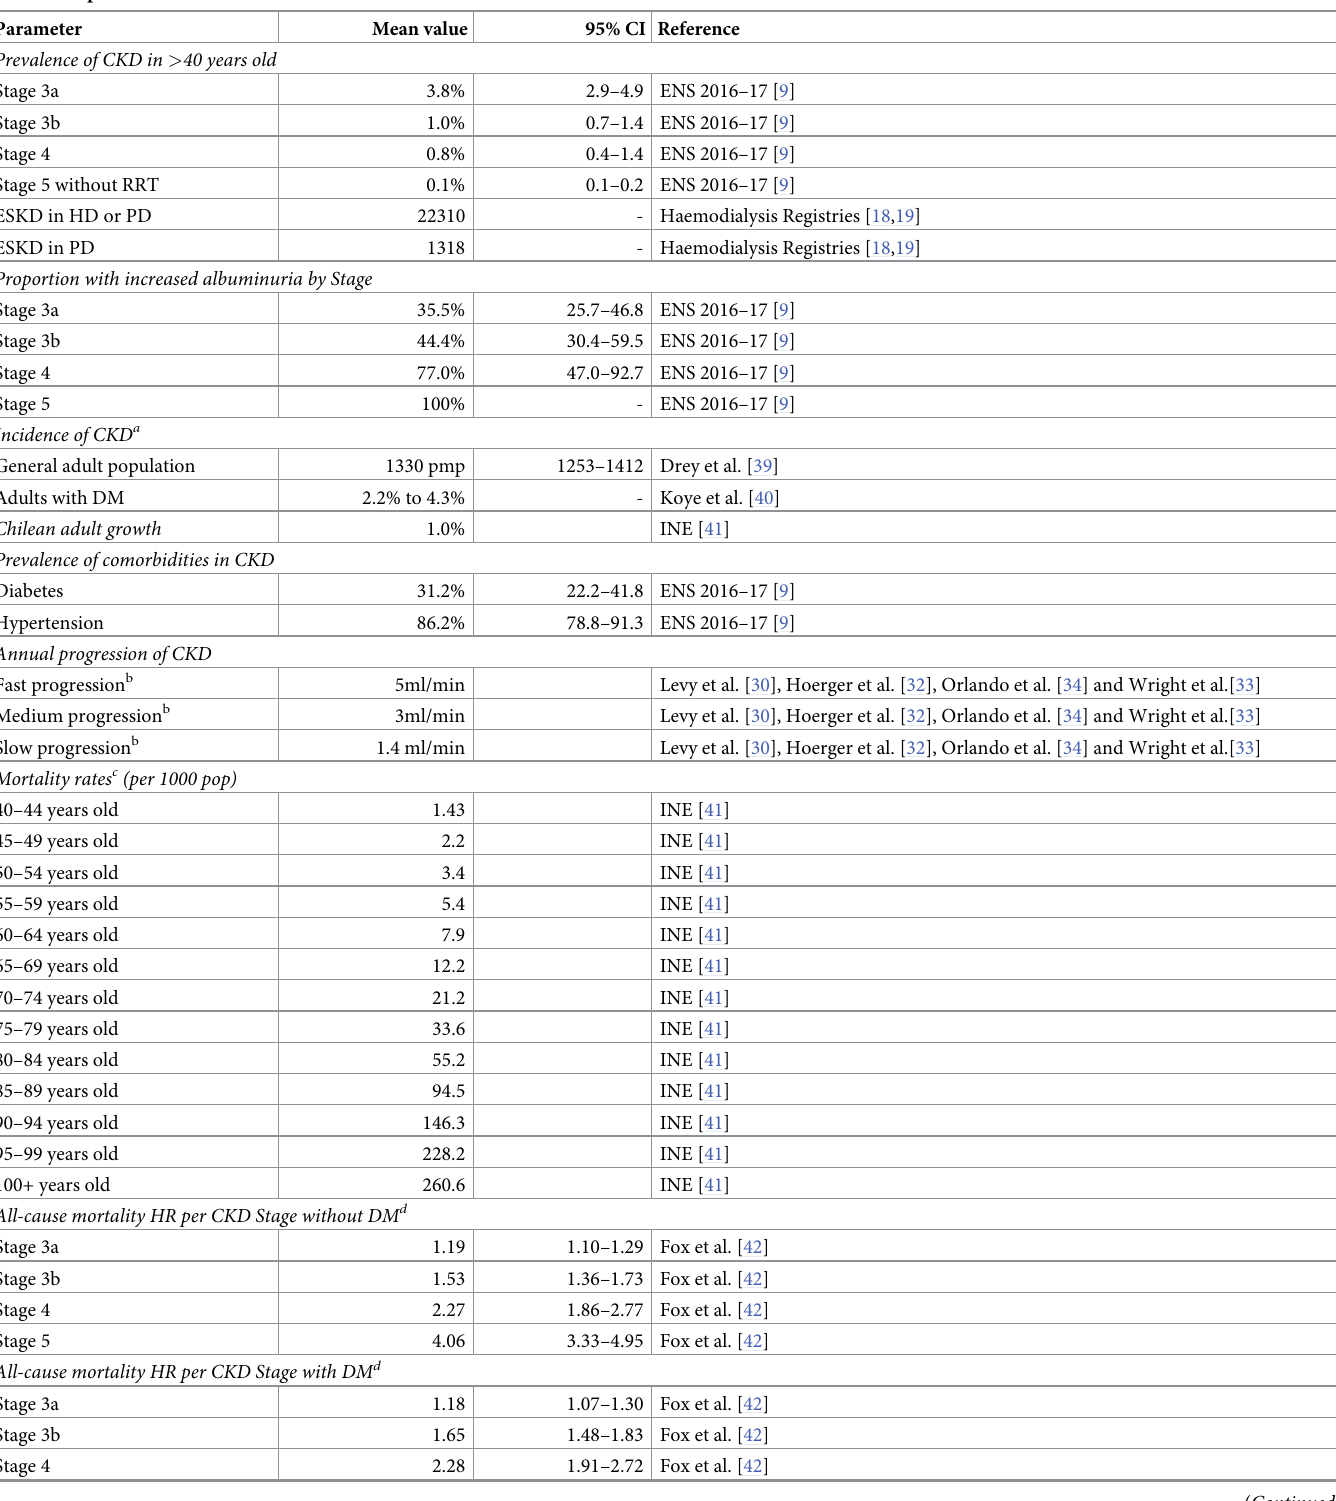
Table 1. Input values used for the stock and flow